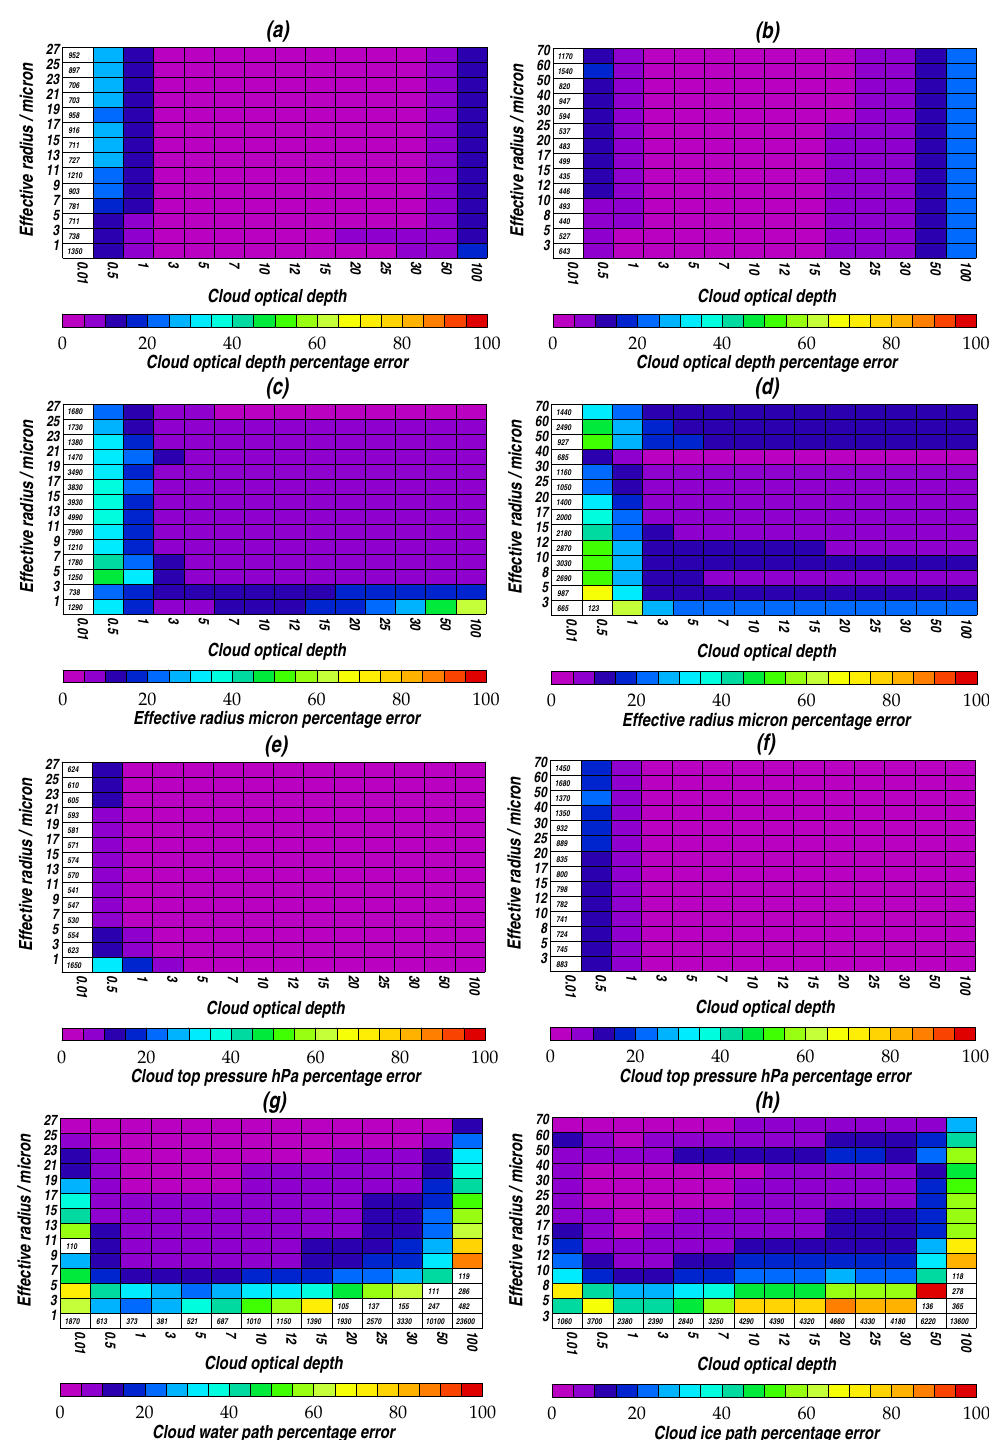
Fig. 2. Simulated retrieval error as a function of varying effective radii and cloud optical depth for cloud optical depth (a) and (b) , effective radius (c) and (d) , cloud top pressure (e) and (f) and cloud liquid/ice path (g) and (h) . Results for simulated liquid (left) and simulated ice (right) single layer cloud over sea. The numbers printed in the white boxes indicate values exceeding the scale of the colour